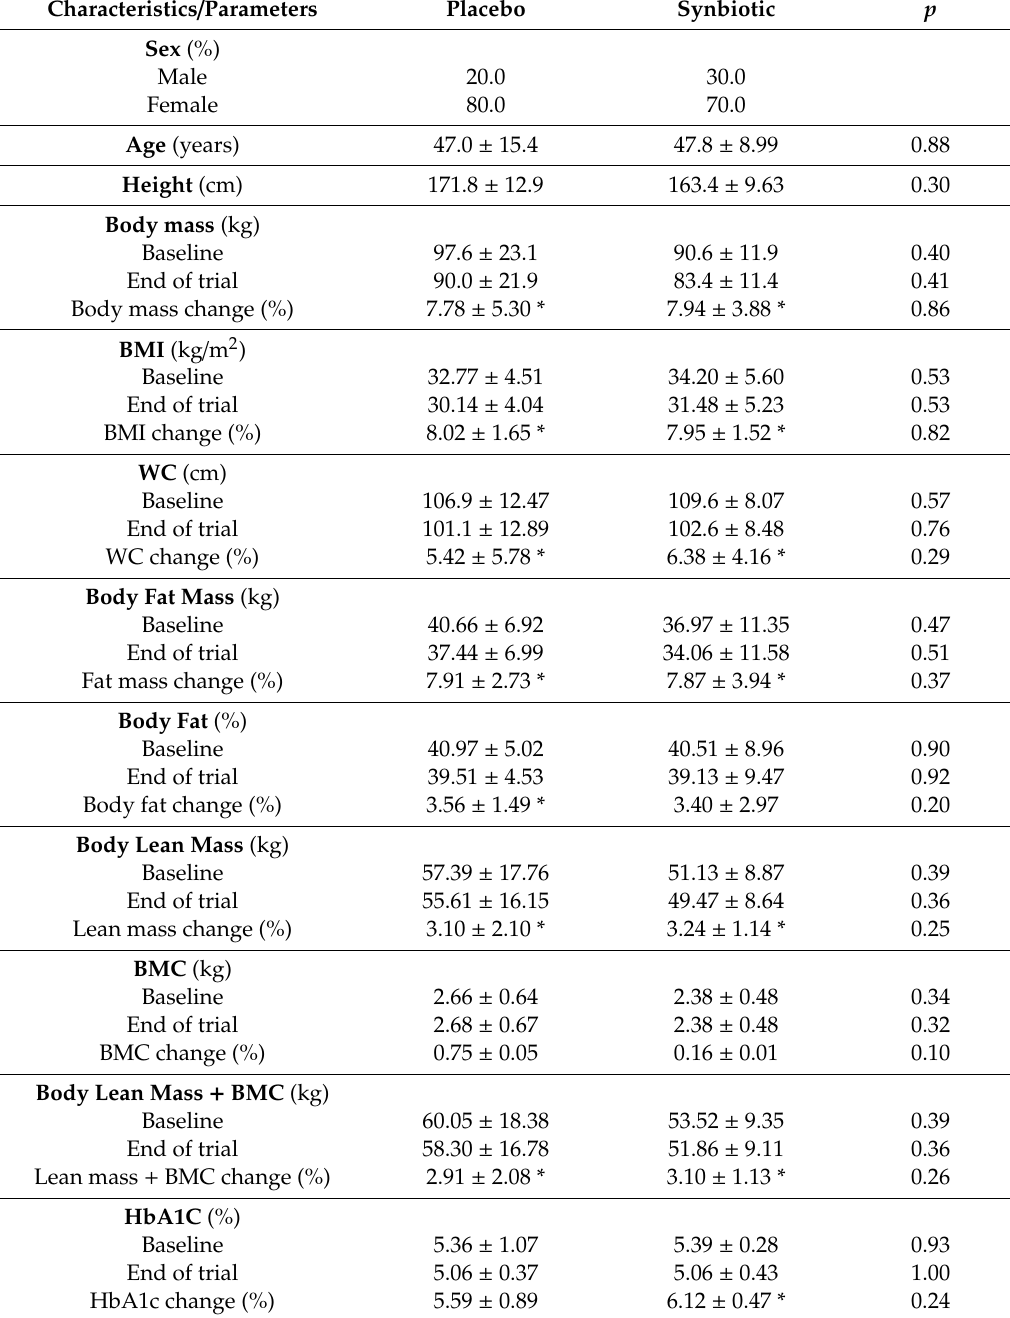
Table 1. Characteristics of study participants at the beginning and end of the intervention clinical trial. BMI, Body Mass Index; WC, Waist Circumference; BMC, Bone Mineral Content; HbA1C, glycated hemoglobin. The duration of the trial was 3 months. The study enrollment period was 6 months, and subjects were assigned to the groups in a chronological order. n = 10 for the placebo group and n = 10 for the synbiotic group (7 subjects in the placebo group and 8 in the synbiotic group completed DXA scans). The results are expressed as mean ± SD. A one-way ANOVA with independent t -test was used for the group comparison (SPSS Statistics, v. 25). (*), p < 0.05, as compared between the beginning (baseline) and end of trial for the same group (placebo or synbiotic); p value, as compared between the placebo and synbiotic